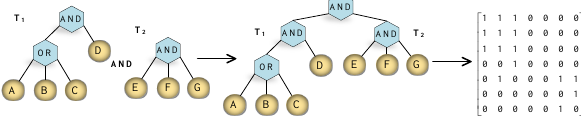
Figure 4. The Process of Generating the Access Tree.